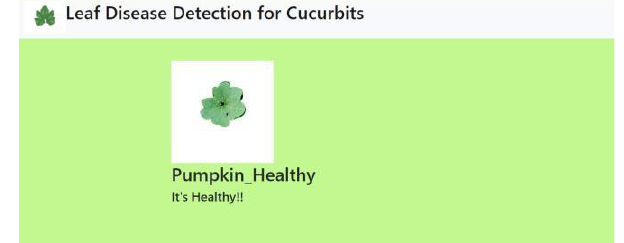
Fig 7. UI of Leaf Disease Detection of Cucurbits .